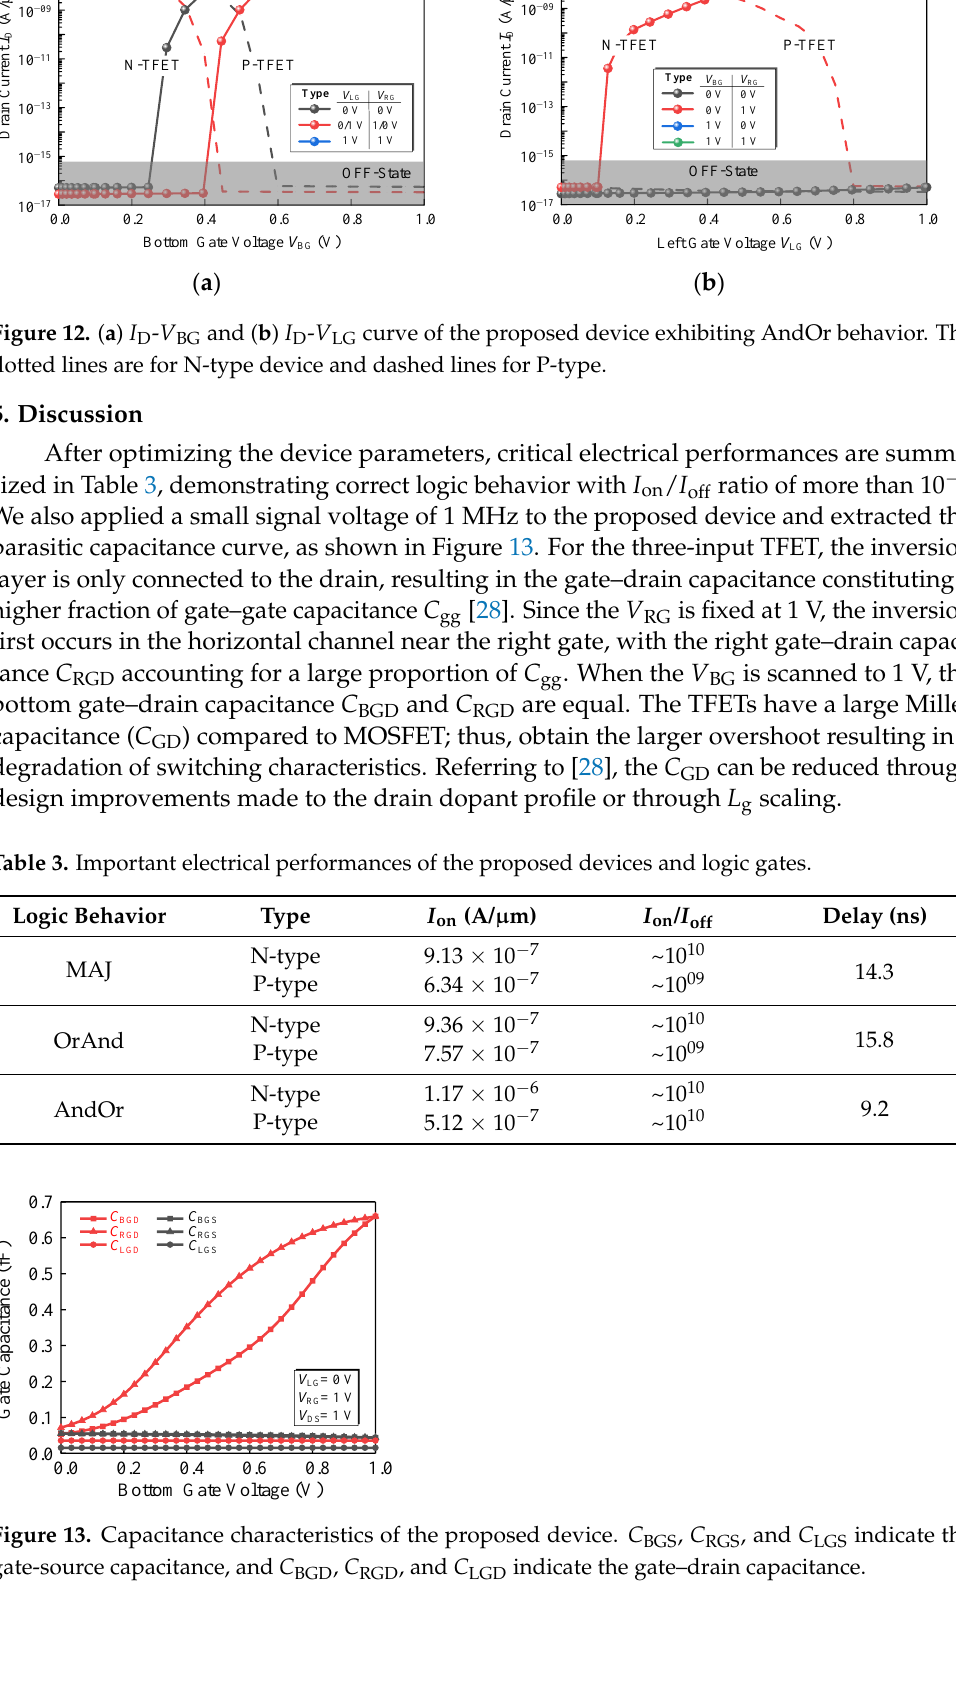
Figure 11. Contour plot of the BTBT generation rate for different gate inputs in AndOr logic device. ( a ) ABC = ” 001 ” , ( b ) ABC = ” 101 ” , ( c ) ABC = ” 110 ” , and ( d ) ABC = ” 111 ” .